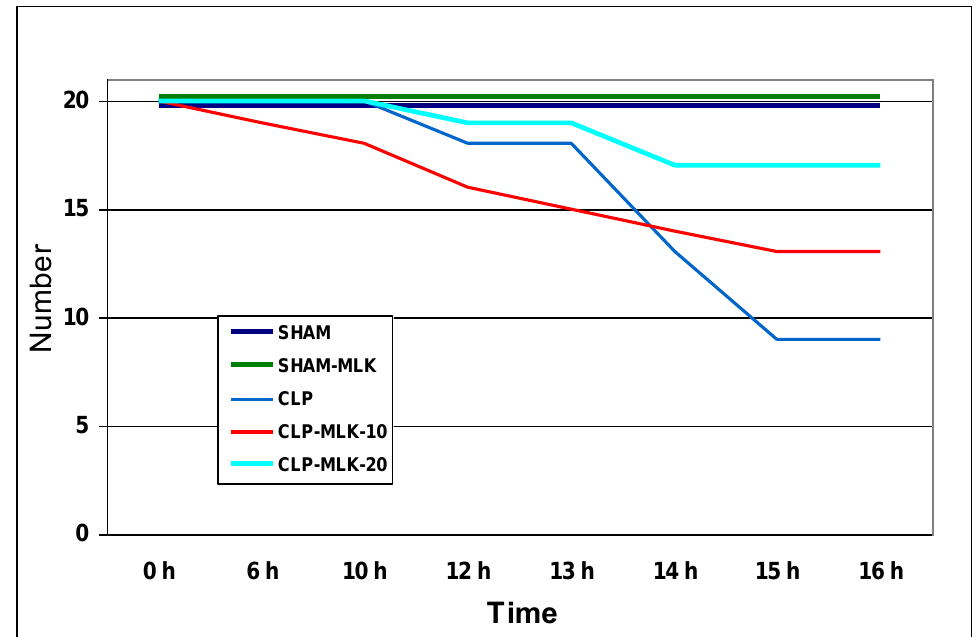
FIGURE 6. The survival graphics of the